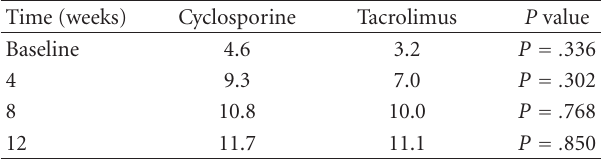
Table 2: Mean tear production (STT) inmm/min at baseline, 4 weeks, 8 weeks, and 12 weeks for the cyclosporine group and the tacrolimus group. There was no di ff erence between groups at any